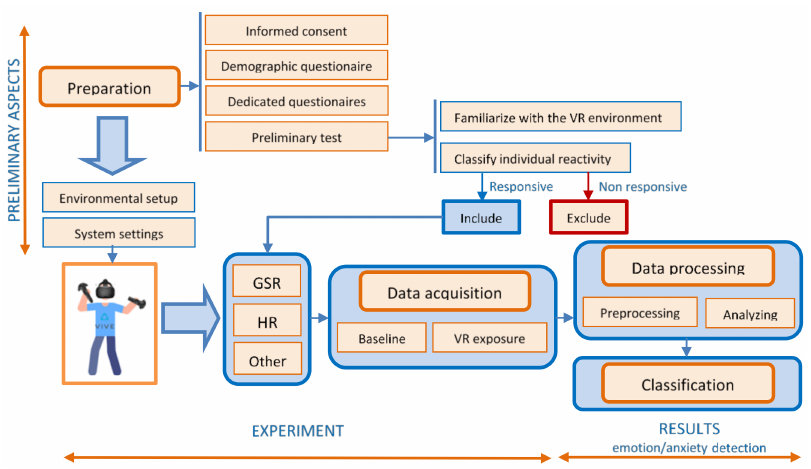
Figure 3. Block diagram of the experimental design and protocol for emotion / anxiety detection in virtual reality